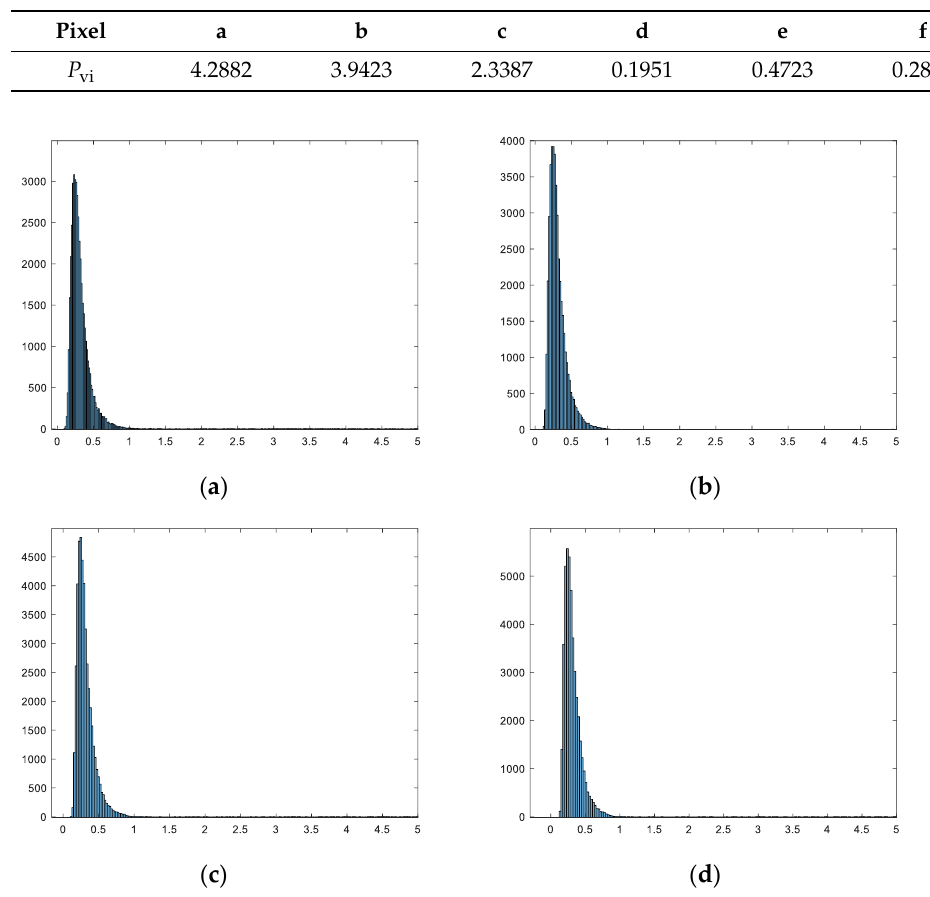
Figure 5. ( a – c ) 𝐼 𝑠 (𝑝 𝑖 ) images of three ship target pixels and ( d – f ) 𝐼 𝑠 (𝑝 𝑖 ) images of three sea clutter pixels. Table 2. P vi of the six pixels in Figure 5.